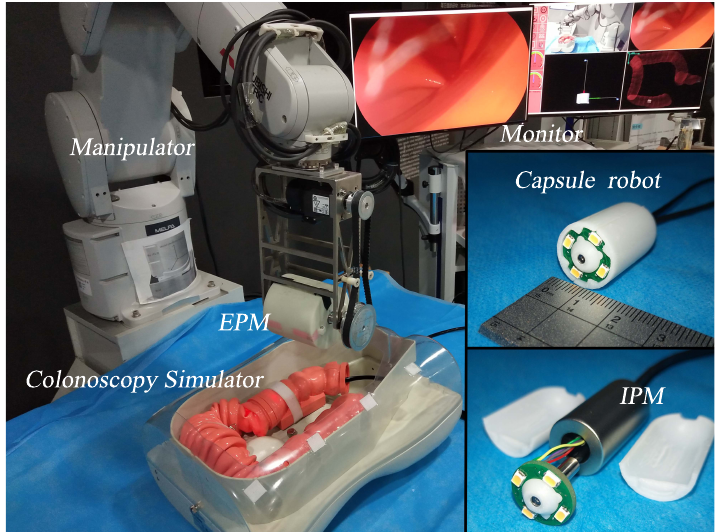
Figure 2. Magnetically-driven capsule endoscopy robot system. IPM, Internal Permanent Magnet; EPM, External Permanent